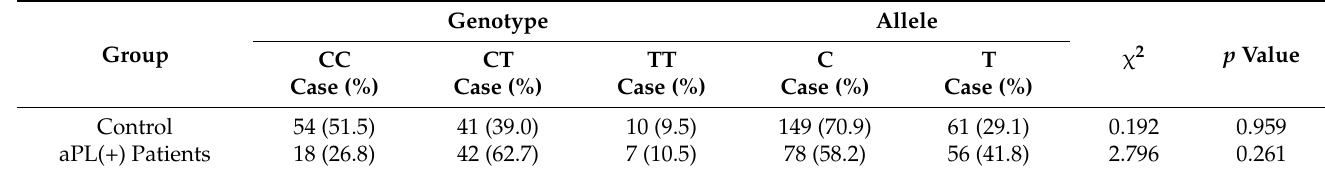
Table 3. MTHFR C667T loci of the Hardy–Weinberg genetic equilibrium test.